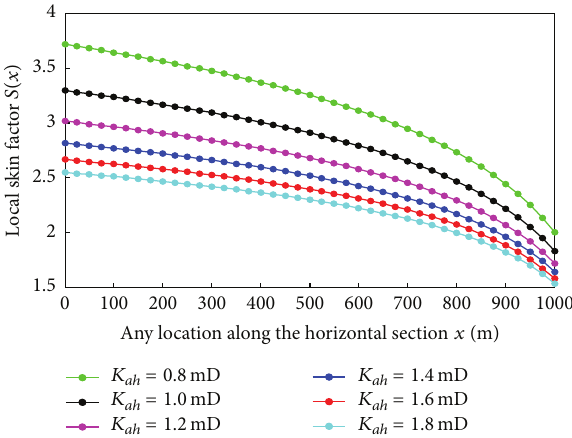
Figure 8: Effect of AZ’s permeability ( 𝐾 𝑎ℎ ) on skin factor ( 𝐿 = = 0.1 m, 𝜀 = 0.00016 m, 𝛾 = 0.56 , 𝜇 = 0.023 mPa ⋅ s, 1000 m, 𝑟 𝑤 𝑔 𝑔 = 20 MPa, 𝐾 = 0.6 mD, 𝑍 = 0.9 , 𝑇 = 366 K, ℎ = 10 m, 𝑝 𝑤𝑓 ℎ = 0.1 mD, 𝐾 = 0.1 mD, 𝑑 = 1.6 m, 𝑑 = 0.2 m, 𝐾 V 𝑑ℎ V . max V . min = 1.2 m, and 𝑎 = 0.15 m). 𝑎 V . max V . min